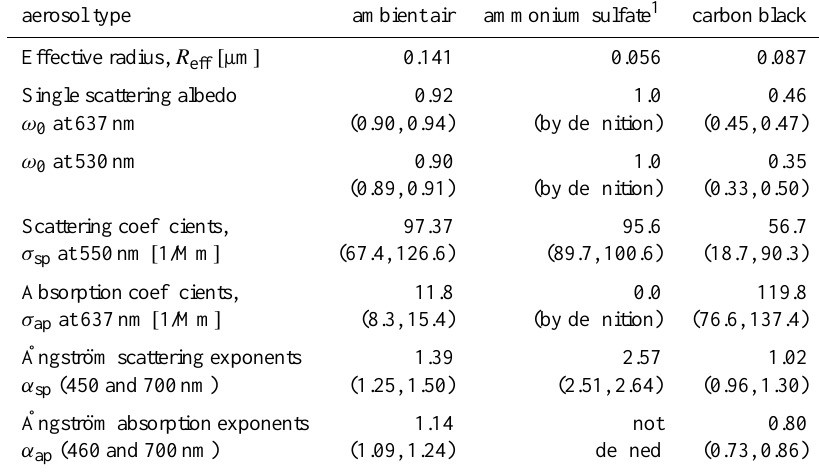
Table 1. Average values of properties of aerosol types used during GAW2005; maximum and minimum values are given between parentheses. Absorption coefficients were measured by PSAP and MAAP and scattering coefficients were determined by a nephelometer.